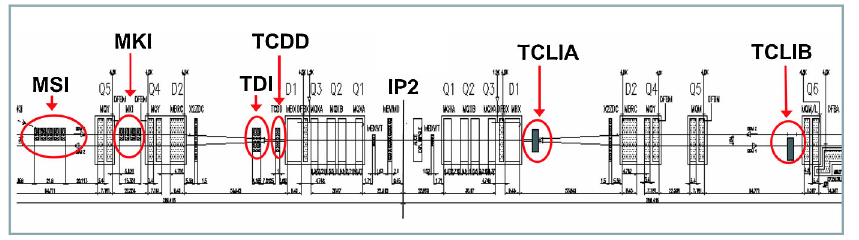
FIG. 3. (Color) Overview of the injection region in IR 2 (distance MSI-TCLIB: (cid:4) 420 m